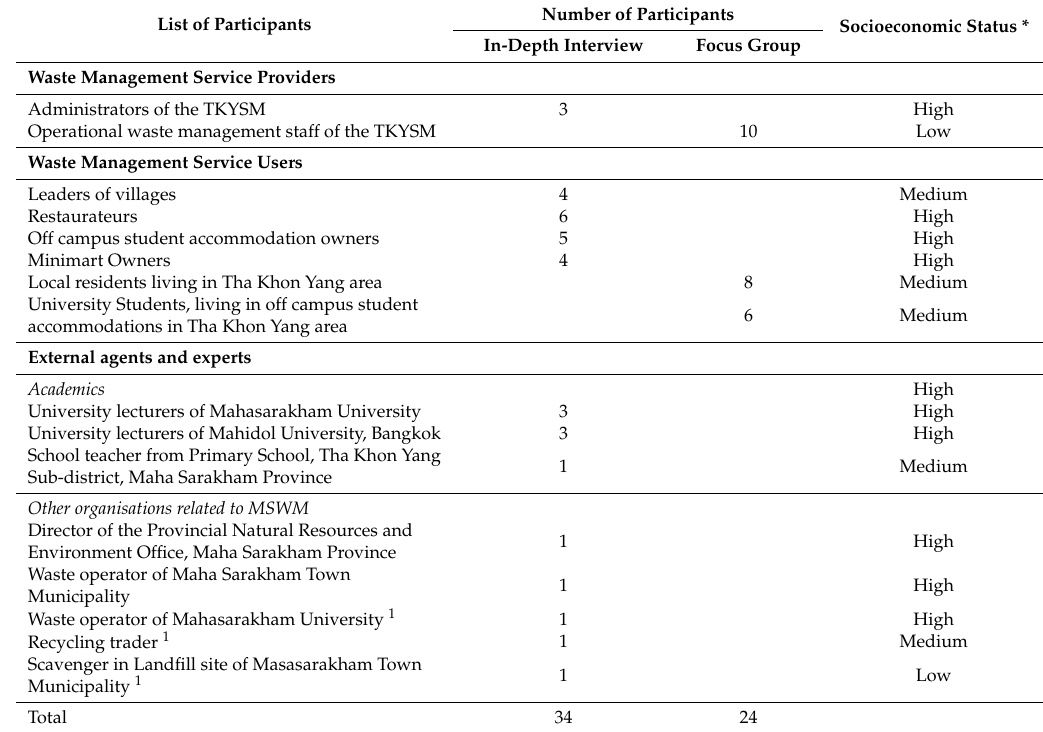
Table 1. In-depth interviews and focus group